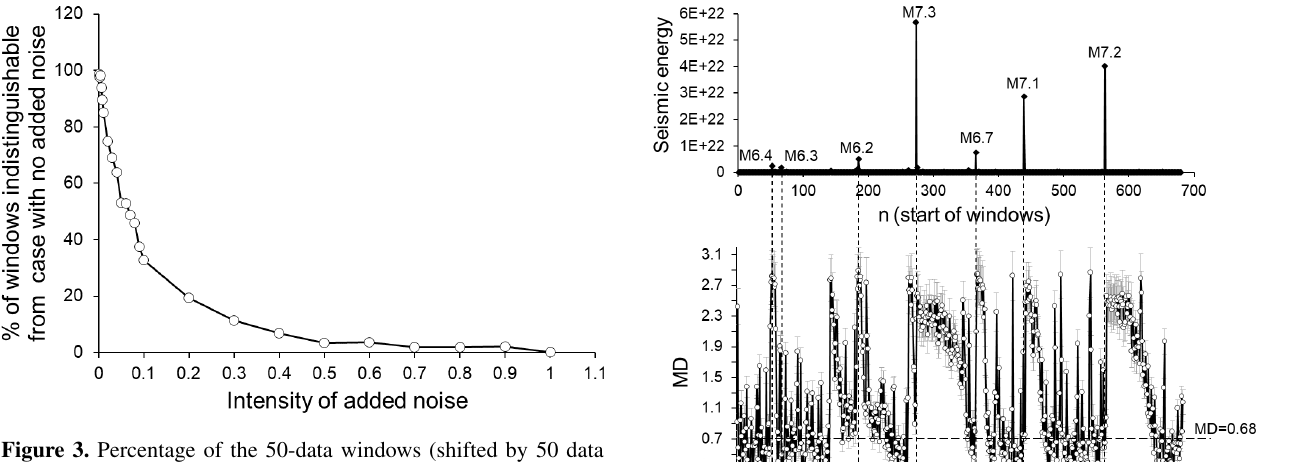
Figure 3. Percentage of the 50-data windows (shifted by 50 data steps) of the Lorenz system with added noise that are indistinguish- able from the initial condition (system with no added noise).